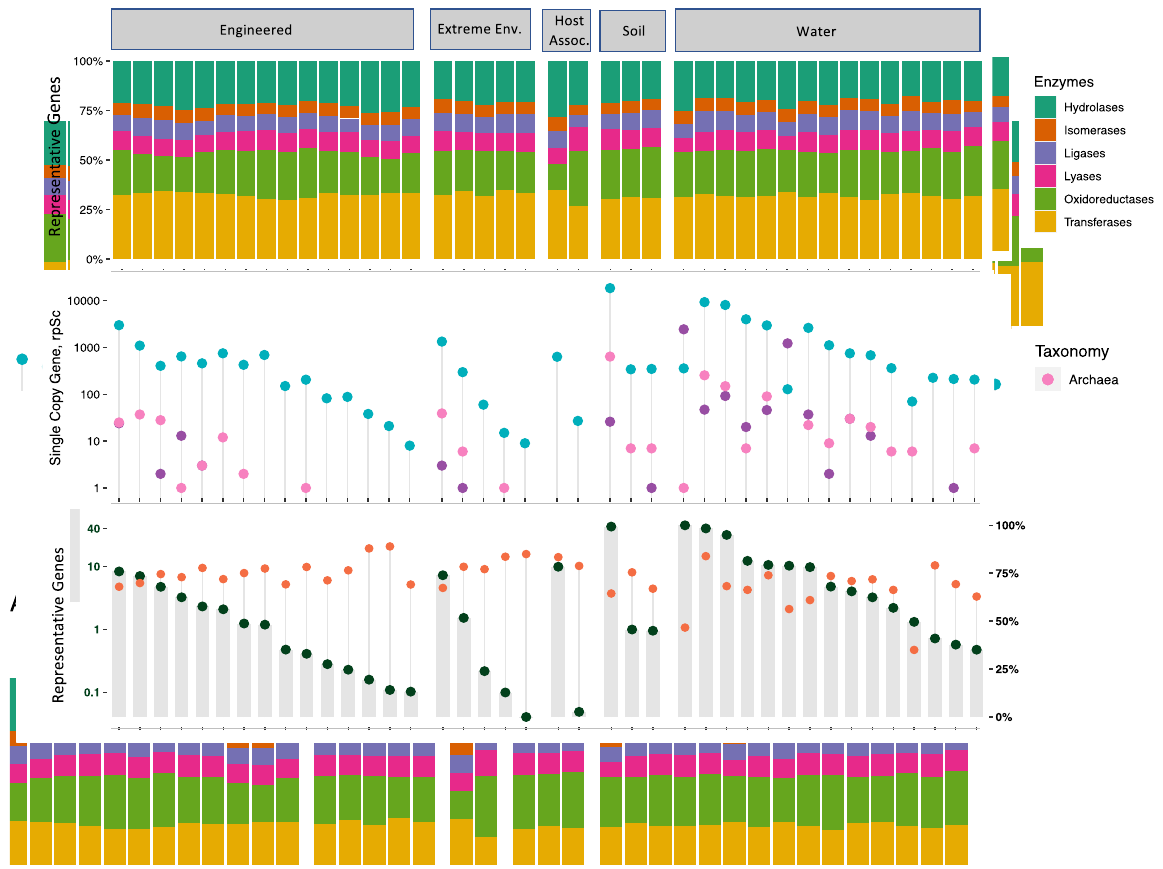
Figure 3. Gene catalogs showing count of habitat specific representative genes. ( A ) The count of total representative genes (million) as well as annotated genes (percent). ( B ) The count of taxon assigned single copy marker gene rpSc (PF01738) is shown on the log scale and ( C ) unique genes labeled with enzymes of different types. This data presents 36 new gene catalogs from ecological metagenomes, marked with initial “e”. Existing four gene catalogs are also included alongside the global metagenomic gene catalog, see Supplementary Table S1 for details on sample count, study accessions and corresponding annotation from